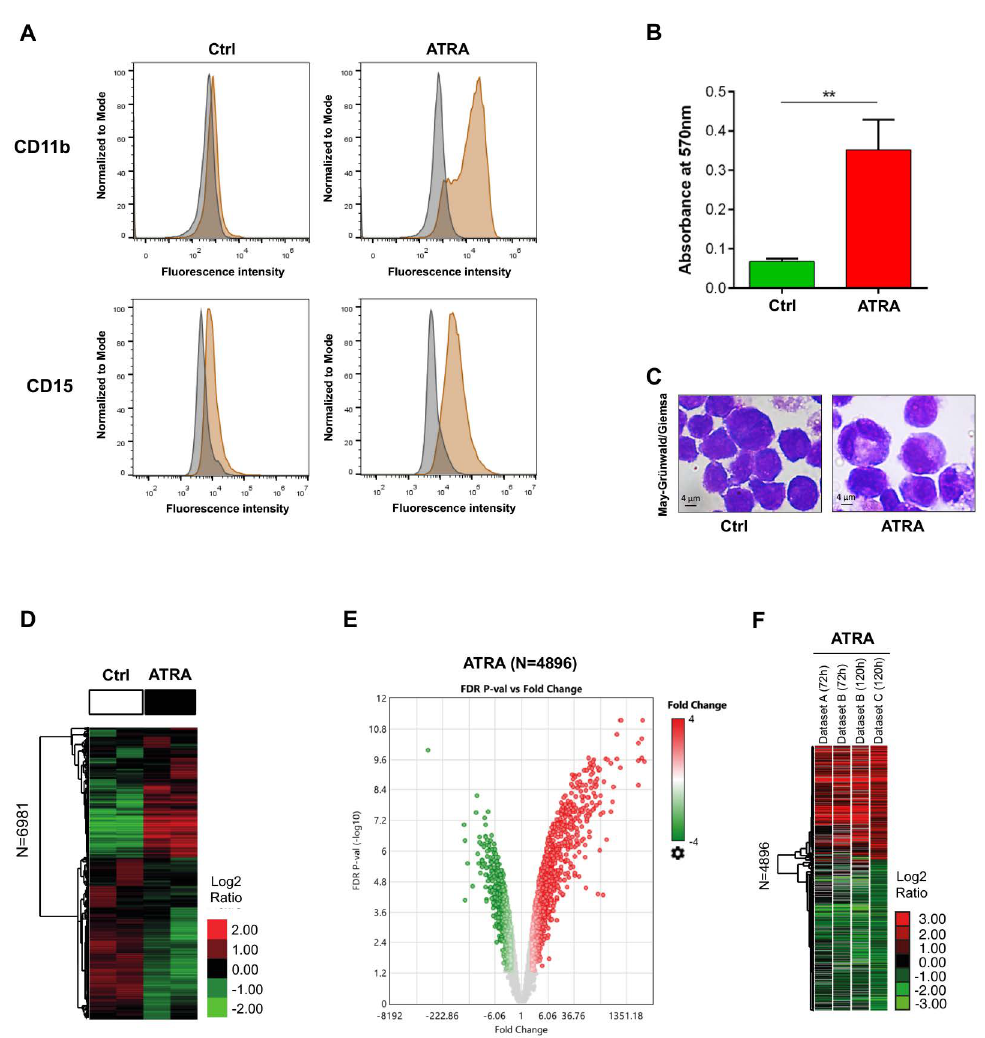
Figure 1. Genes expression profile of all- trans retinoic acid (ATRA)-treated NB4 cells. ( A ) Flow cytometric analysis of CD11b and CD15 expression in NB4 cells treated with 1 µ M ATRA for 120 h (ATRA) or with the only vehicle as control (Ctrl). Gray plots represent autofluorescence; orange plots represent CD11b and CD15 fluorescence in ATRA-treated and Ctrl cells. ( B ) NBT test performed in NB4 cells treated with 1 µ M ATRA for 120 h (ATRA) or with the only vehicle as control (Ctrl). Absorbance was measured at 570 nm. Mean values were derived from three independent experiments ± SD (Student’s t-test, ** p < 0.01). ( C ) May-Grünwald / Giemsa staining of NB4 cells either untreated (Ctrl) or exposed to ATRA for 120 h (ATRA). ( D ) Hierarchical clustering analysis of high variable transcripts ( n = 6981) in ATRA- and vehicle-treated cells. The heatmap represents the Log2 ratio of the expression (median centered) of genes as per the legend. ( E ) Volcano plot showing the relationship between magnitude of gene expression change in ATRA- vs. vehicle-treated cells (Fold Change, X -axis) and statistical significance of differential expression (–Log10 of False Discovery Rate, FDR p -value, Y -axis). Up-regulated (FC ≥ 1.5; n = 2117) and down-regulated (FC ≤ -1.5; n = 2779) genes are indicated by red and green dots, respectively. ( F ) Hierarchical clustering analysis using ATRA-regulated genes ( n = 4896) in other external gene expression datasets of NB4 cells treated with ATRA. Dataset A: NB4 cells treated with 1 µ M ATRA for 72 h (GEO Database accession #: GSE53259) [52]. Dataset B: NB4 cells treated with 1 µ M ATRA for 72 and 120 h (GEO Database accession #: GSE131325) [45]. Dataset C: NB4 cells treated with 1 µ M ATRA for 120 h (present results) (GEO Database accession #: GSE155779). The heatmap represents the Log2 ratio (ATRA vs. ctrl) of genes expression as per the legend. Next, we compared two external gene expression datasets (RNAseq data) of NB4 cells treated with 1 µ M ATRA for 72 h (i.e., Dataset A, GEO database, accession #: GSE53259; and Dataset B-72h